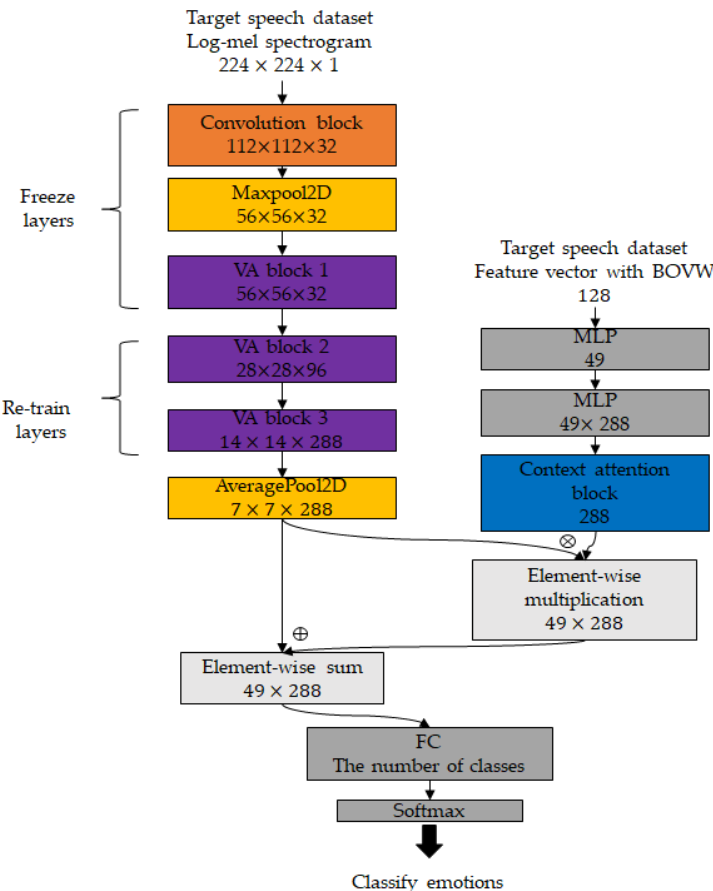
Figure 3. Architecture of the proposed fine-tuned model.